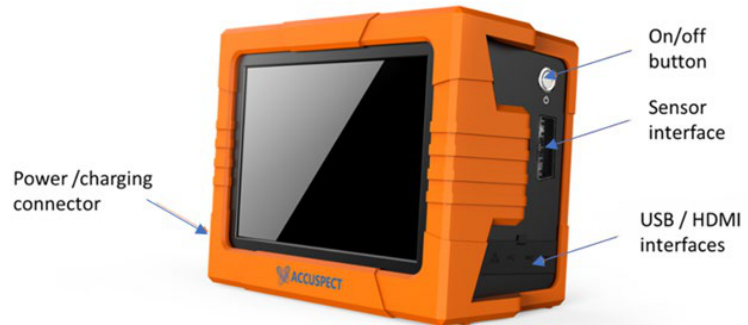
Figure 9. Self-designed and constructed EC testing instrument.